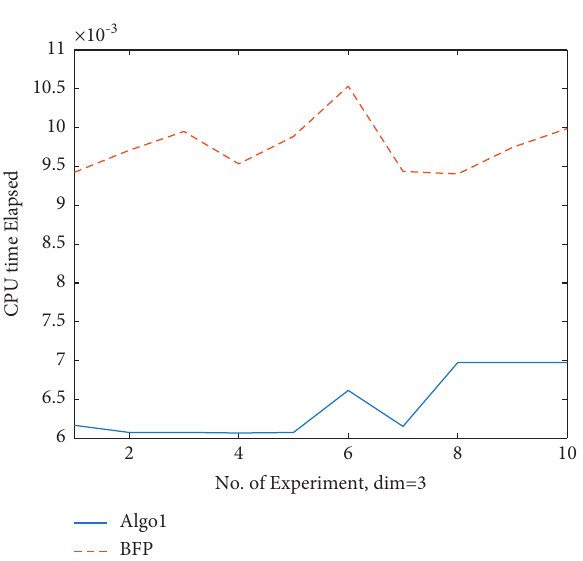
Figure 5: CPU time vs no. of iteration for dimension